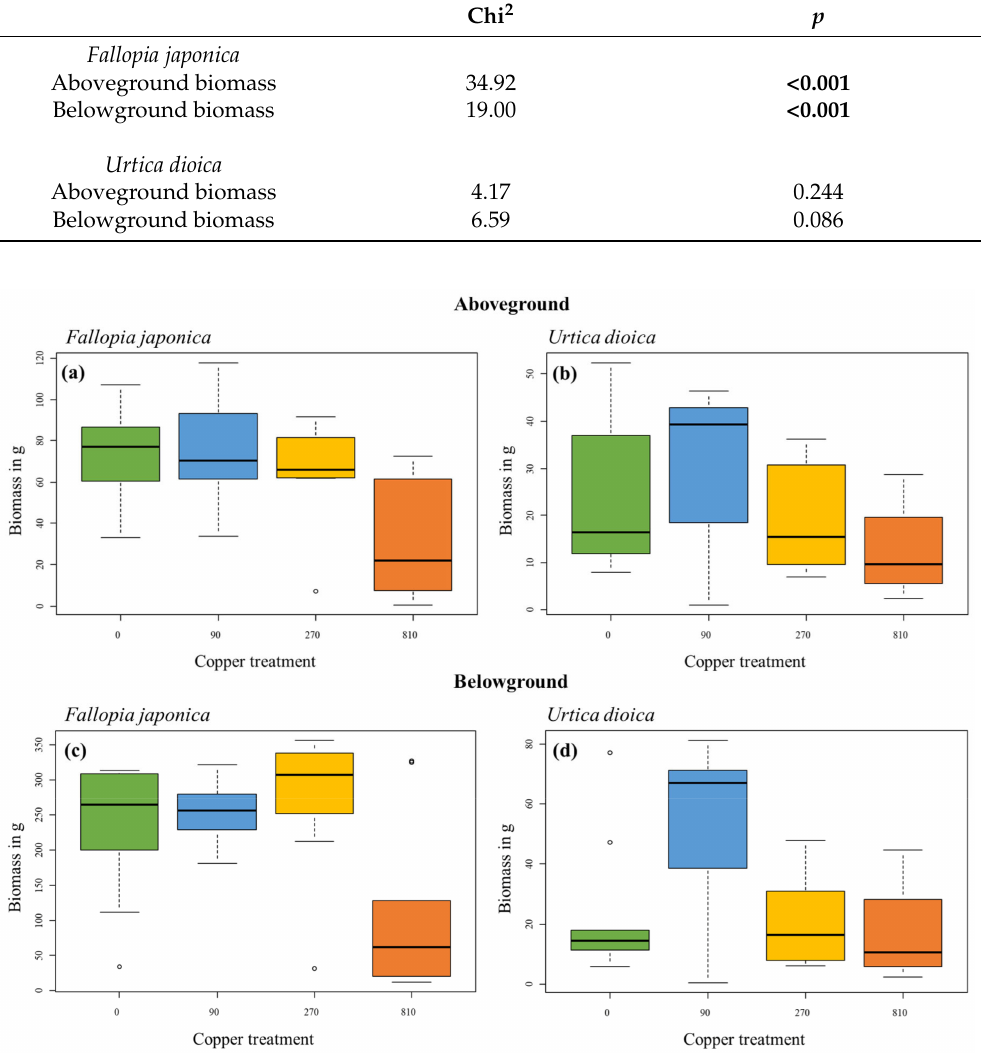
Figure 2. Biomass of above- and belowground plant material of Fallopia japonica and Urtica dioica collected at the end of the growing season in each copper treatment (n = 10 replicates). Shown are boxplots with median values represented by the black line. Each color corresponds to one cop- per treatment from control to 810 mg kg − 1 copper. ( a ) Aboveground biomass of Fallopia japonica , ( b ) aboveground biomass of Urtica dioica , ( c ) belowground biomass of Fallopia japonica , ( d ) below- ground biomass of Urtica dioica